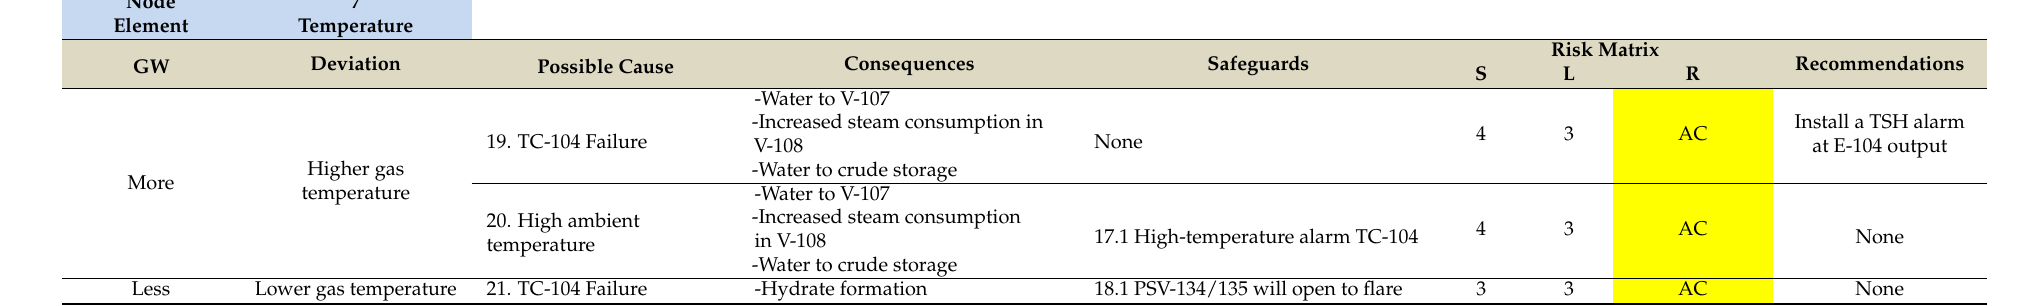
Table 8. HAZOP study results for the deviations specified in the SCOPI’s Node #7 concerning the element “Temperature”, in association with (i) risk-matrix outcomes and the SC coding, and (ii) the depiction of appropriate guidewords, possible causes, consequences, safeguards and recommendations. Node